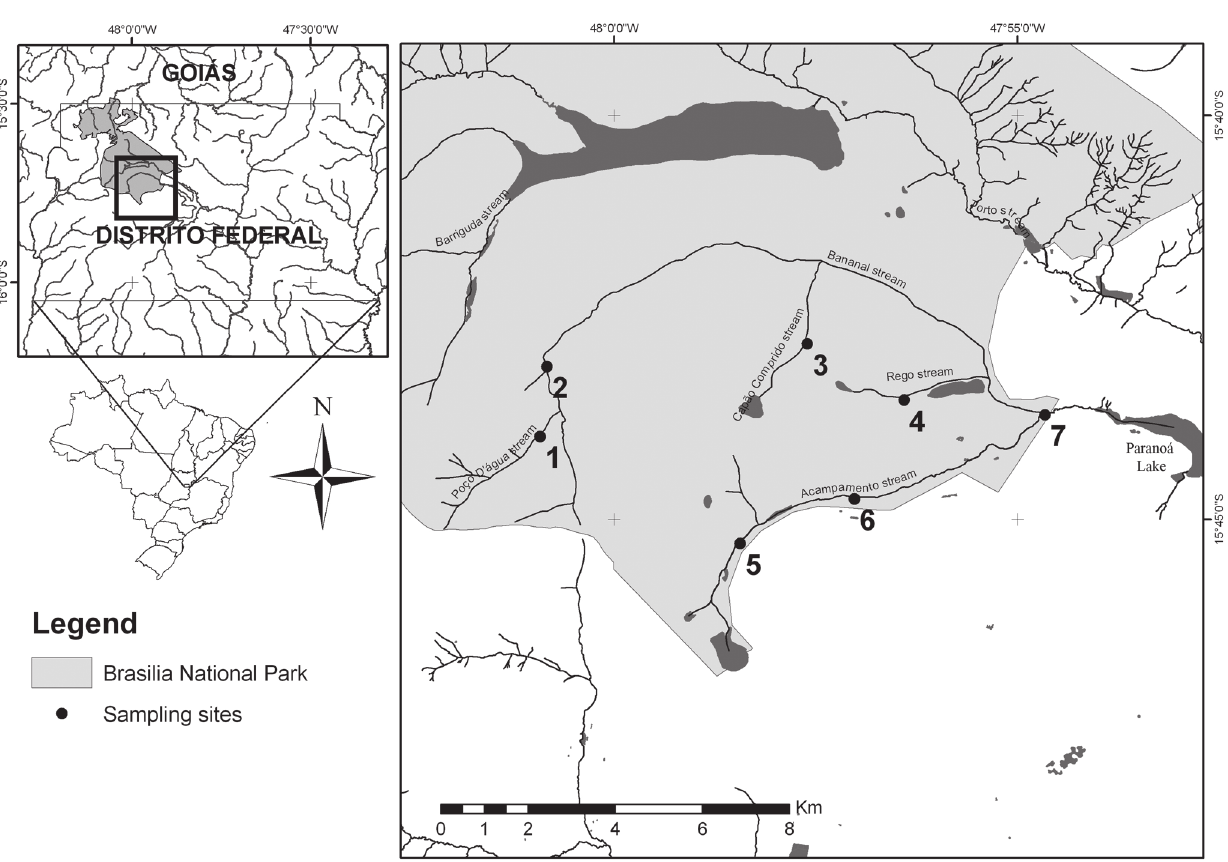
Fig. 1. Localization of the Brasília National Park in the Distrito Federal and distribution of sampling sites in the Bananal stream subbasin, Paranoá Lake basin,